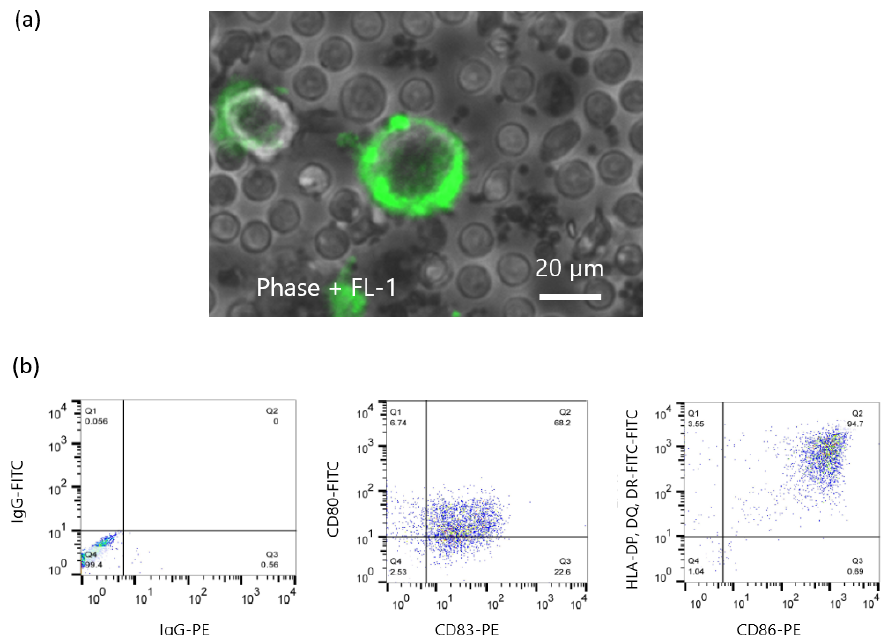
Figure 6. Immature DCs-captured iPSL and phenotyping characterization of activated iPSL/DCs. ( a ) The photo depicts entrapped FITC-labeled annexin-V-binding iPSL in an immature DC. The photo was captured within 2 h after co-culture. ( b ) Flow cytometric characterization of TNF- α -activated DCs. The activated DCs expressed the activated markers CD80, CD83, CD86, and HLA-DR.